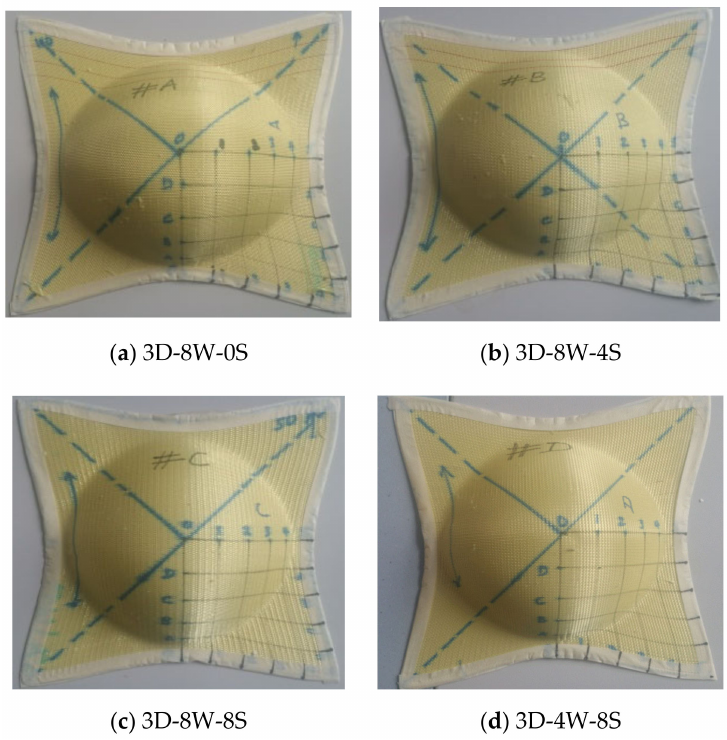
Figure 6. 3D warp interlock preforms after